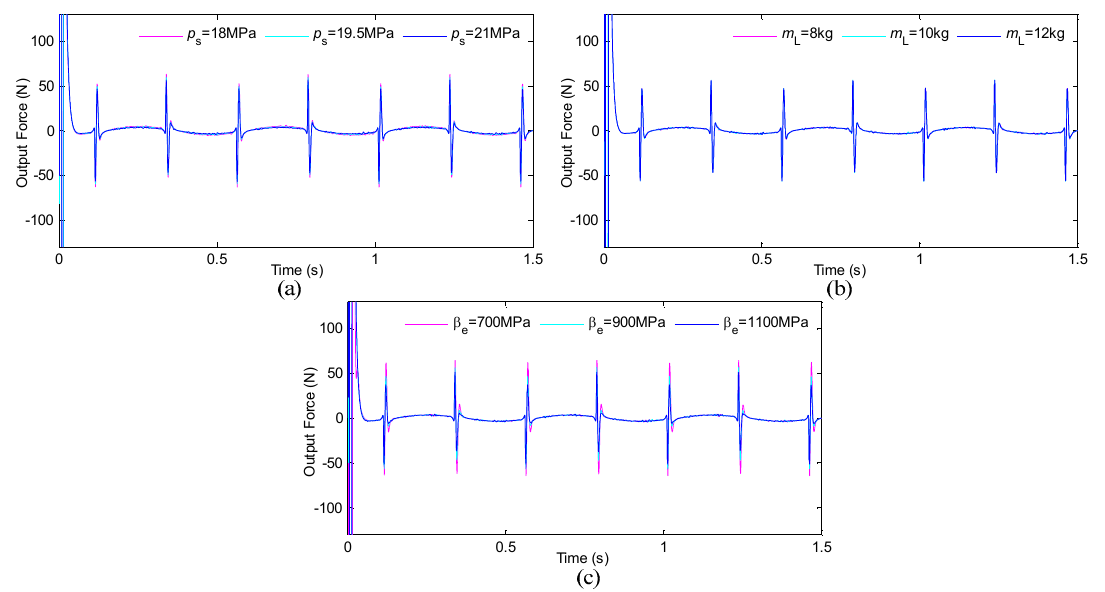
p ; ( b ) with perturbation s